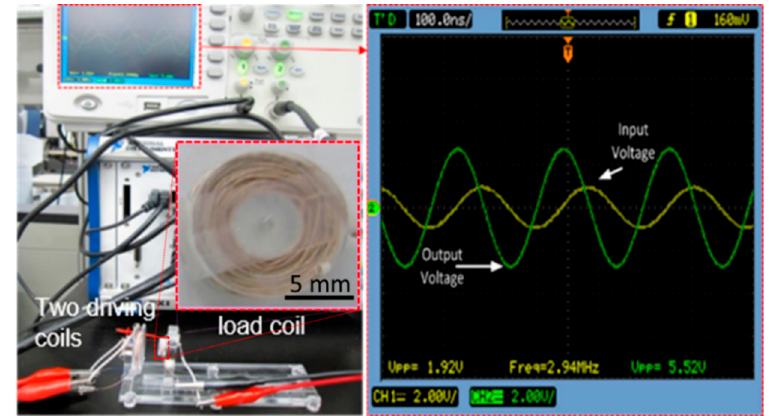
Figure 8. The experimental setup for the three-coil WPT system ( left ); The measurement results of the input voltage (on driving coil) and output voltage (on load coil), d 23 = 20 mm ( right ).